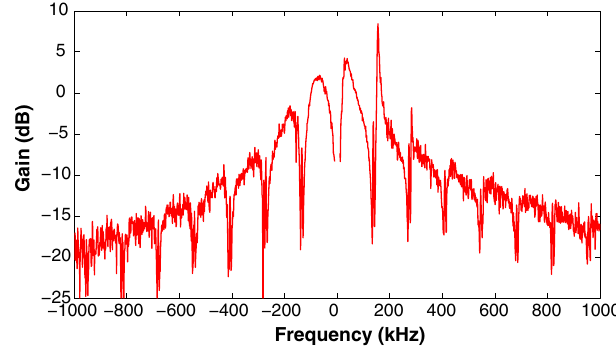
FIG. 19. (Color) Measured transfer function magnitude from LER 4-2 at 1500 mA during run 5b, showing comb rotation induced distortion with the original amplifiers.